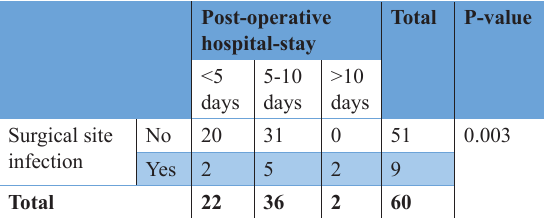
Table 4. Correlation between surgical site infection